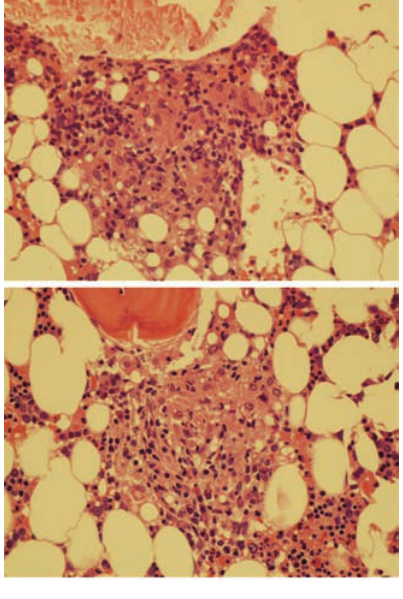
Figure 1. Non-caseating granulomas on bone marrow biopsy (hematoxylin and eosin stain; magnification: